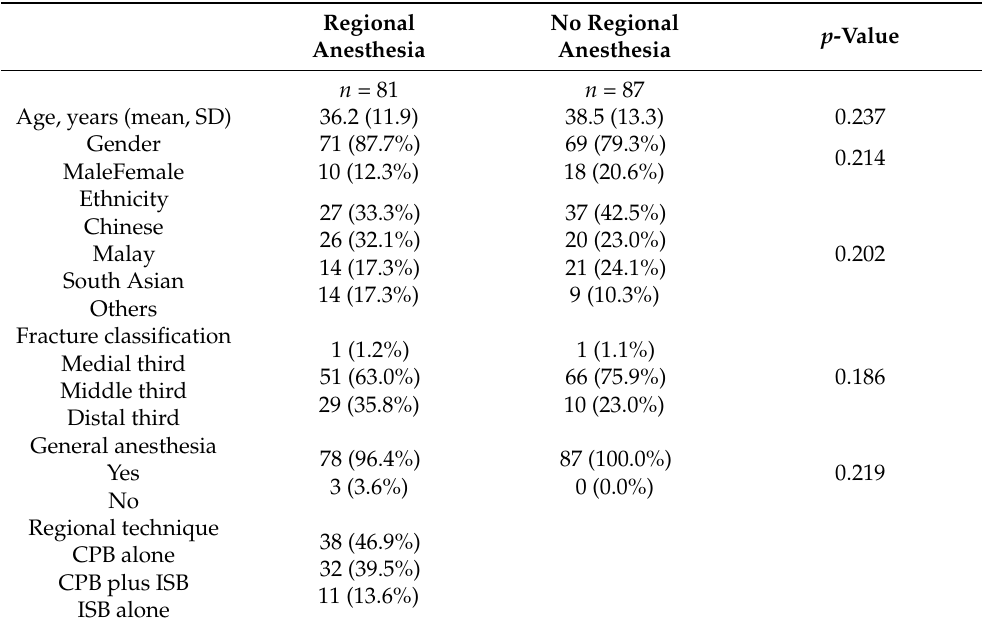
Table 1. Characteristics of patients included in the